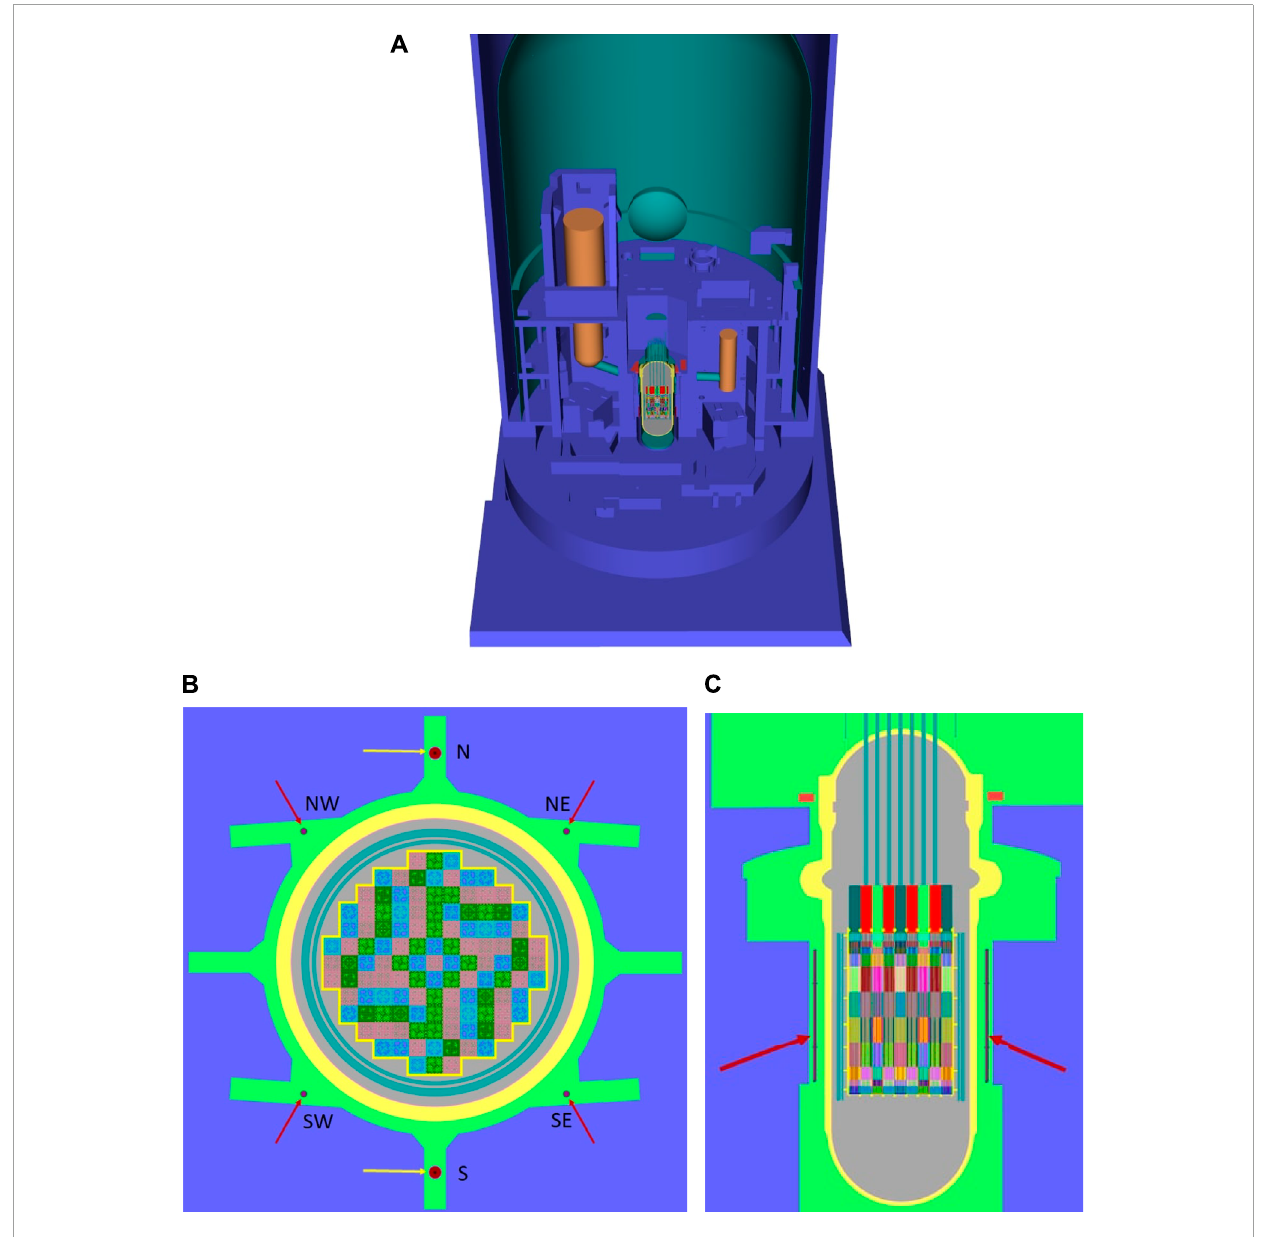
FIGURE 5 Schematic view of computational MCNP containment building model with ex-core power range detector locations. Detector locations are marked with red arrows. Figures were generated with Radiant utility within the ADVANTG used for rendering images of MCNP geometry models in a